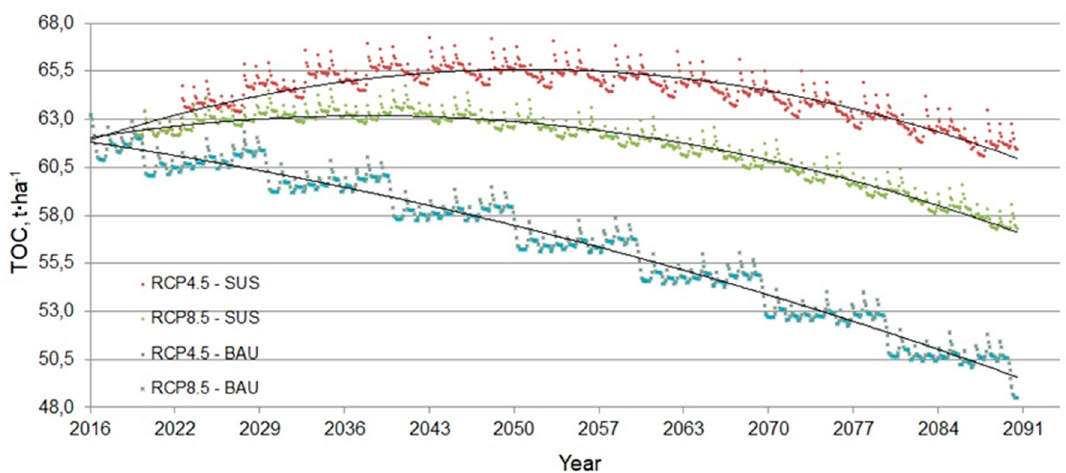
Figure 8. The dynamics of total SOC stocks for various crop rotations calculated using the RothC model for 2016–2090 in the control treatment under the RCP4.5 and RCP8.5 climate scenarios. The trend line is a polynomial of the second degree.